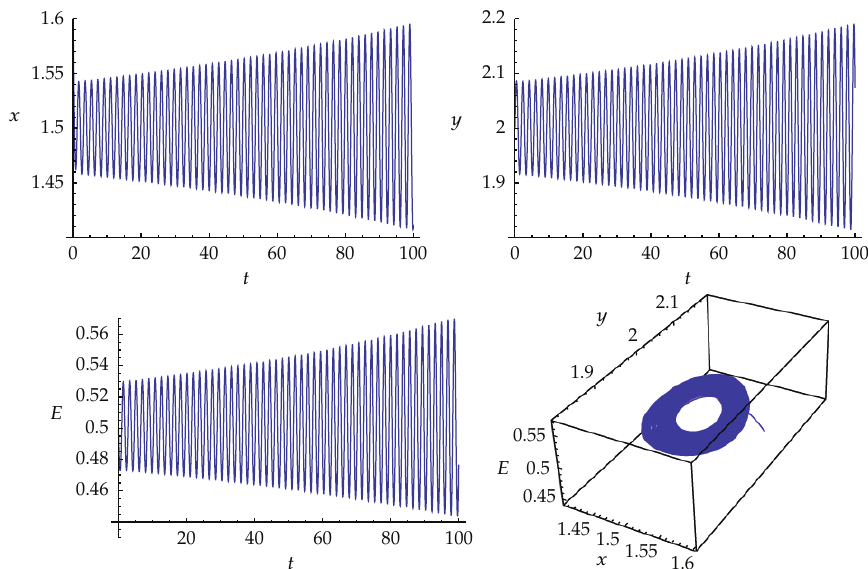
Figure 3: Dynamic behavior of the di ff erential-algebraic system (cid:6) 3.1 (cid:7) with τ (cid:5) 0 . 57 > τ (cid:8) equilibrium point P (cid:8) is